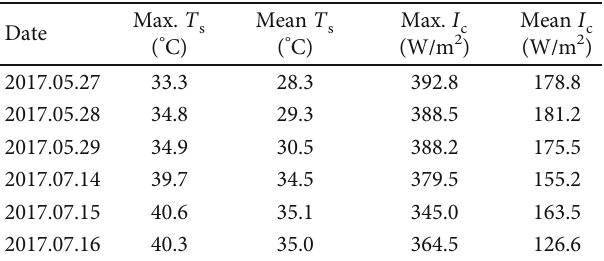
Figure 4: Solar irradiation intensity and ambient temperature. Table 4: Test results of ambient temperature and solar irradiation